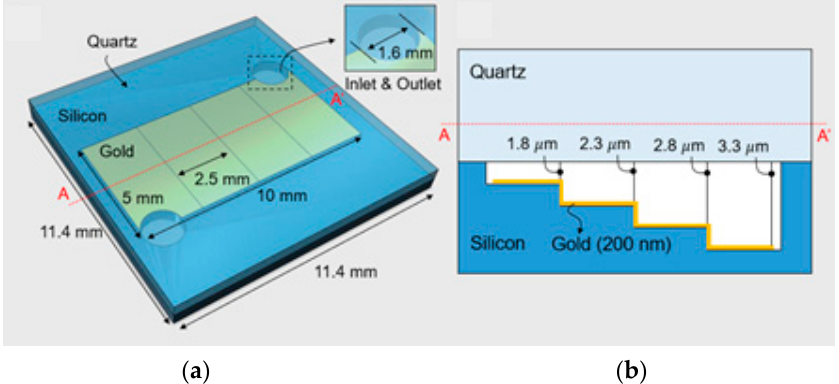
Figure 3. Otto configuration-based SPR sensor chip with stepped air-gap height: ( a ) schematic view; ( b ) cross-section view.